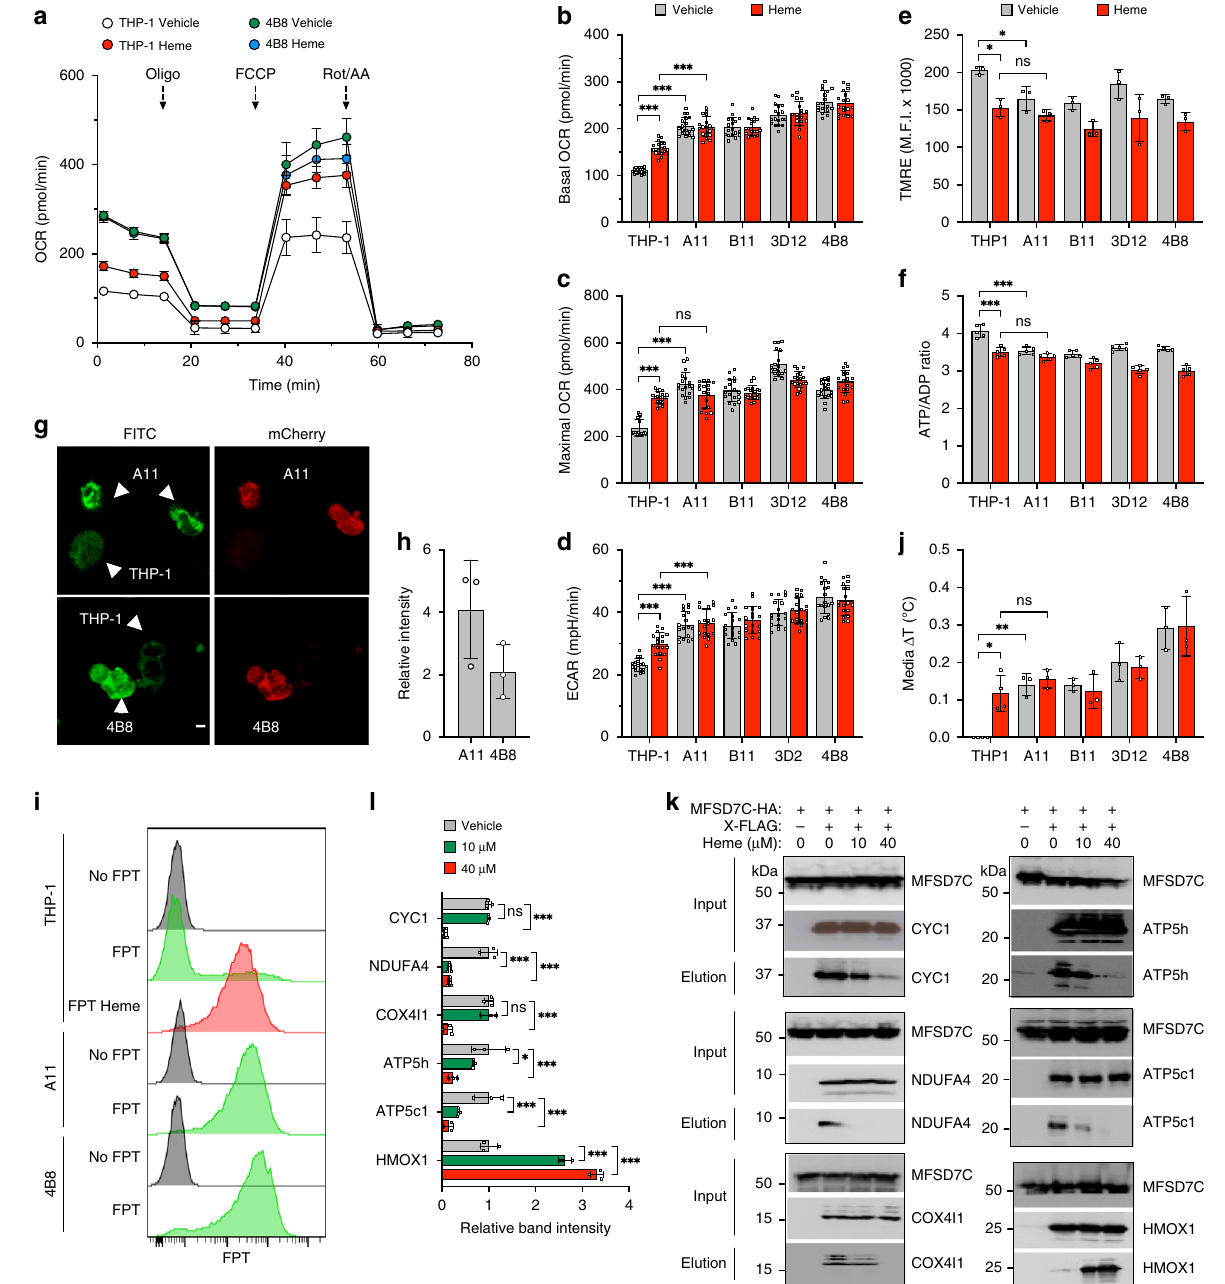
Fig. 2 MFSD7C and heme regulate coupling of mitochondrial respiration. a – f Comparison of mitochondrial respiratory activities between parental THP-1 cells and four Mfsd7c knockout clones (A11, B11, 3D12, and 4B8). Parental and knockout THP-1 cells were cultured in the presence of either vehicle or 40 µ M heme for 1 h. a Representative OCR measurements of THP-1 cells and 4B8 knockout clone under the indicated conditions. Comparison of basal OCR ( b ), maximal OCR ( c ), and ECAR ( d ), between THP-1 cells and 7CKO clones from three separate experiments. Each dot represents a technical replicate ( b – d , n = 18 independent experiments). e MMP was measured using TMRE (200 nM) by fl ow cytometry ( n = 3 independent experiments). f Cellular ATP/ADP ratio ( n = 5 independent experiments). g , h Comparison of thermogenesis between parental THP-1 cells and two 7CKO clones (A11 and 4B8) by microscopy using FPT. Green channel detects the FPT intensity and the red channel distinguishes knockout cells, which expressed mCherry, from the parental THP-1 cells. Shown are representative images ( g ) and FPT intensity of A11 and 4B8 relative to THP-1 cells from three separate experiments ( h ). i Comparison of thermogenesis between THP-1 and 7CKO cells by fl ow cytometry. FPT fl uorescence intensity was quanti fi ed by fl ow cytometry. Shown are representative plots from three separate experiments. j Comparison of temperature changes in THP1 ( n = 4 independent samples) and 7CKO ( n = 3 independent samples) culture media ( Δ T) with or without heme treatment as measured by thermocouples. k and l Cells were not treated or treated with heme for 1 h before lysis. Cell lysates were precipitated with anti-FLAG antibody, eluted with FLAG peptide, then precipitated with anti-HA antibody, and eluted with HA peptide, and fi nally subjected to immunoblotting with anti-HA and anti-FLAG antibodies. Input is the total cell lysate. Shown are representative co-IP/immunoblots ( k ) and average band intensities with standard deviation from three independent experiments ( l ). p values were calculated using two-way ANOVA (* p < 0.05, ** p < 0.01, *** p < 0.005). Data are presented as mean value ± standard